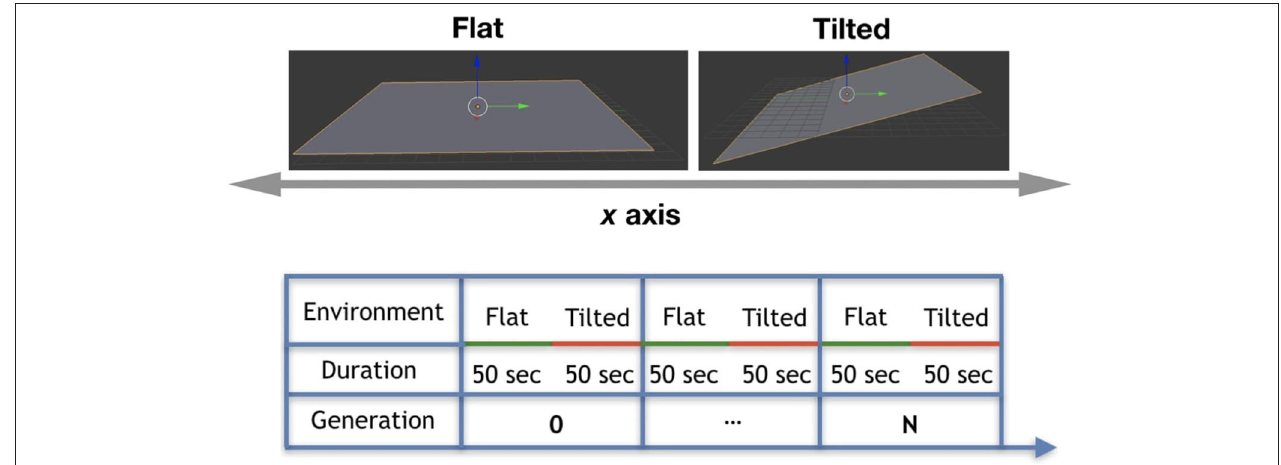
FIGURE 9 | (Top) Environmental conditions: Flat and Tilted. (Bottom) Cycle of seasonal environmental